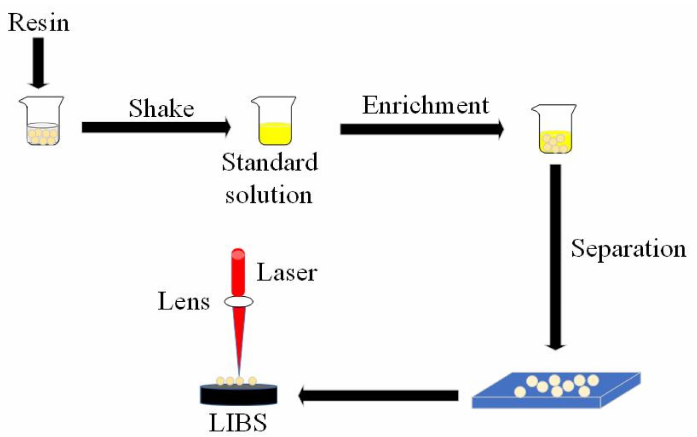
Figure 2. Schematic diagram of sample preparation